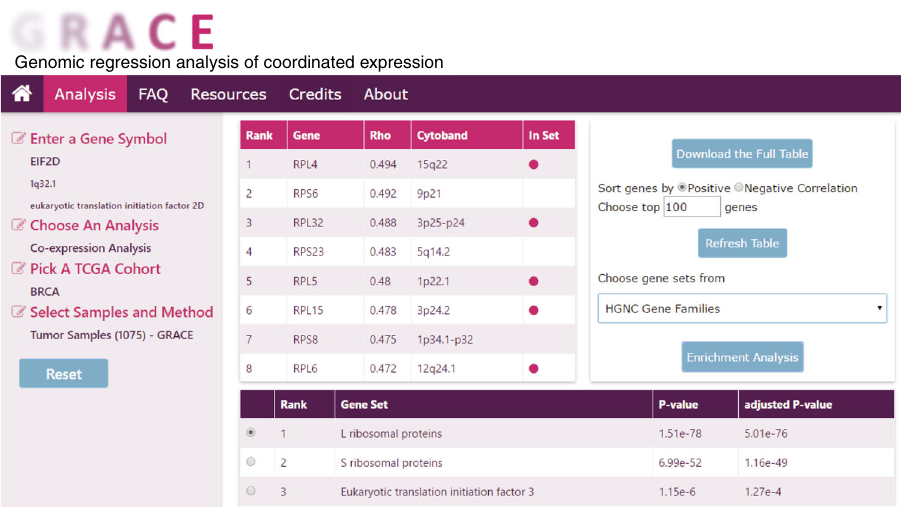
Fig. 5 Co-expression analysis in web database GRACE. In the analysis page of the web database GRACE, upon entry of gene name, selection of “ co- expression analysis ” as the type of analysis and speci fi cation of cohort, sample types and method, a table of co-expressing genes will be generated. The result will include Spearman rank correlation coef fi cient and the chromosomal location for the co-expressing genes. Users may click the co-expressing gene names to be redirected to external websites for more information. Additional follow up analysis options are also provided. The user may download the full list of co-expressing genes, refresh the table with user speci fi ed sorting order and length of gene list, or run an enrichment analysis with a gene set library of their choice. In the resulting table of top enriched gene sets, the user may select from different gene sets and identify their members by the magenta dot in the “ In Set ” column of the co-expressing gene